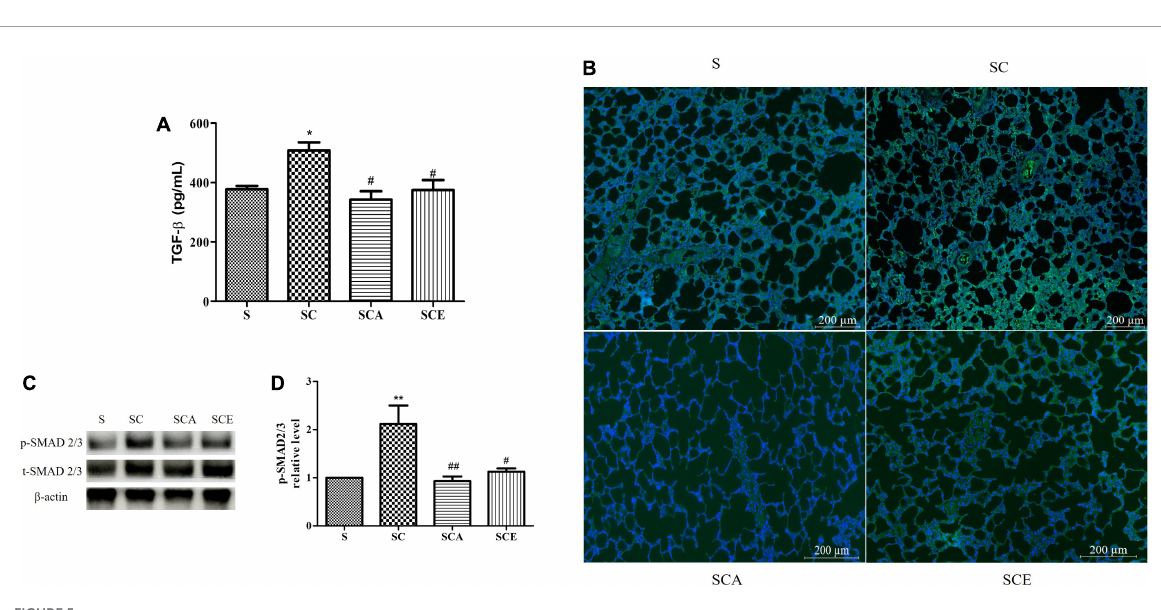
FIGURE5 Effects of atorvastatin and ezetimibe treatment on lung TGF- β /Smad signaling pathway in high-cholesterol fed rats. (A) Transforming growth factor-beta (TGF- β ); (B) transforming growth factor-beta receptor (TGF- β R) immunofluorescence staining; (C) western blot bands of phosphorylated Smad2/3 (p-Smad2/3), total Smad2/3 (t-Smad2/3) and beta-actin ( β -actin) expression in lung tissues; (D) quantification of lung p-Smad2/3 expression. Data are presented as mean ± SEM. * p < 0.05; ** p < 0.01 vs. the control group; # p < 0.05; ## p < 0.01 vs. the SC group ( n = 6 per